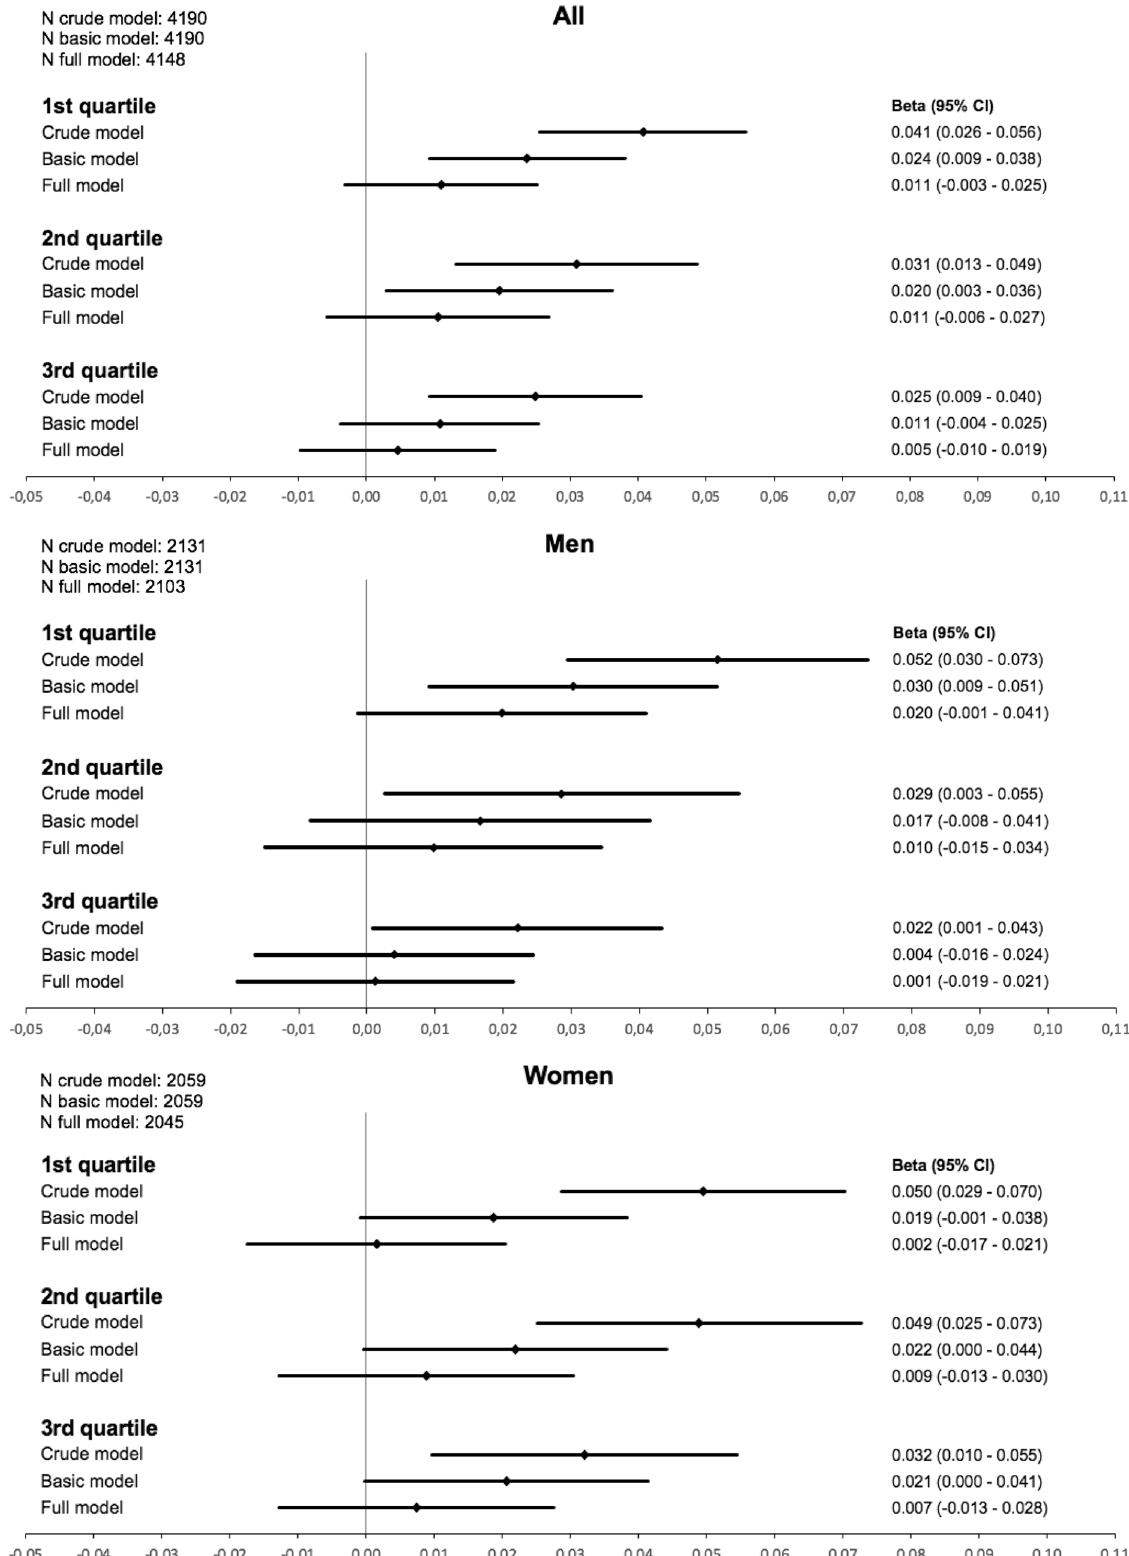
Figure 2. Beta estimates and 95% confidence intervals (95% CI) for the association of income quartiles (4th quartile as reference) with cystatin C in linear regression models (basic model: adjusted for age (+ sex); full model: age (+ sex), BMI, hypertension, diabetes, hs-CRP, total cholesterol, HDL, triglycerides,